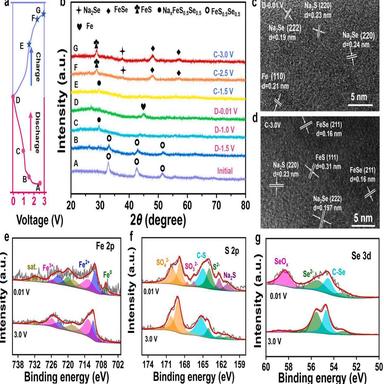
Ex-situ characterizations of cycled FeS0.5Se0.5@NC electrodes: (a, b) XRD, (c, d) HRTEM, XPS spectra of (e) Fe 2p, (f) S 2p and (g) Se 3d at different discharge/ charge states for the first cycle.